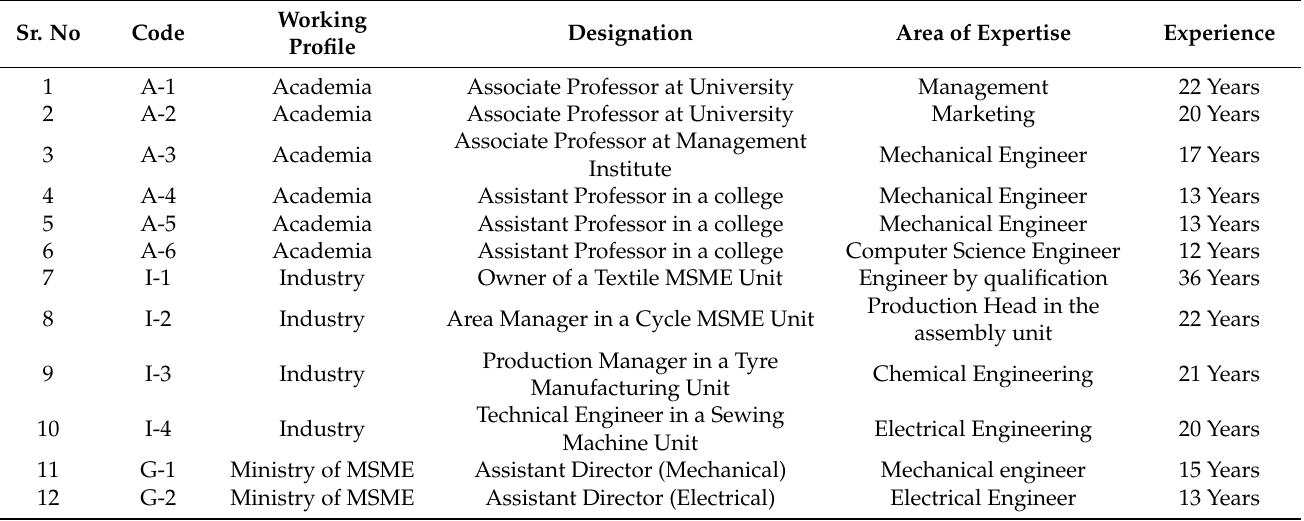
Table 2. Experts team for